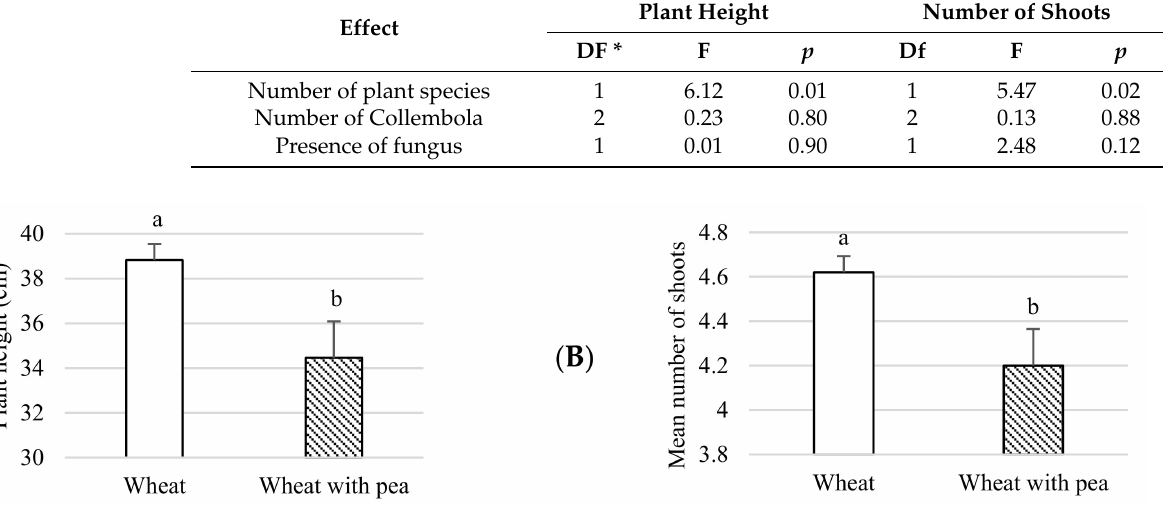
Figure 2. Plant height ( A ) and the mean number of shoots ( B ) of winter wheat grown individually and in the mixture with pea. The different lowercase letters indicate significant differences between treatments, p ≤